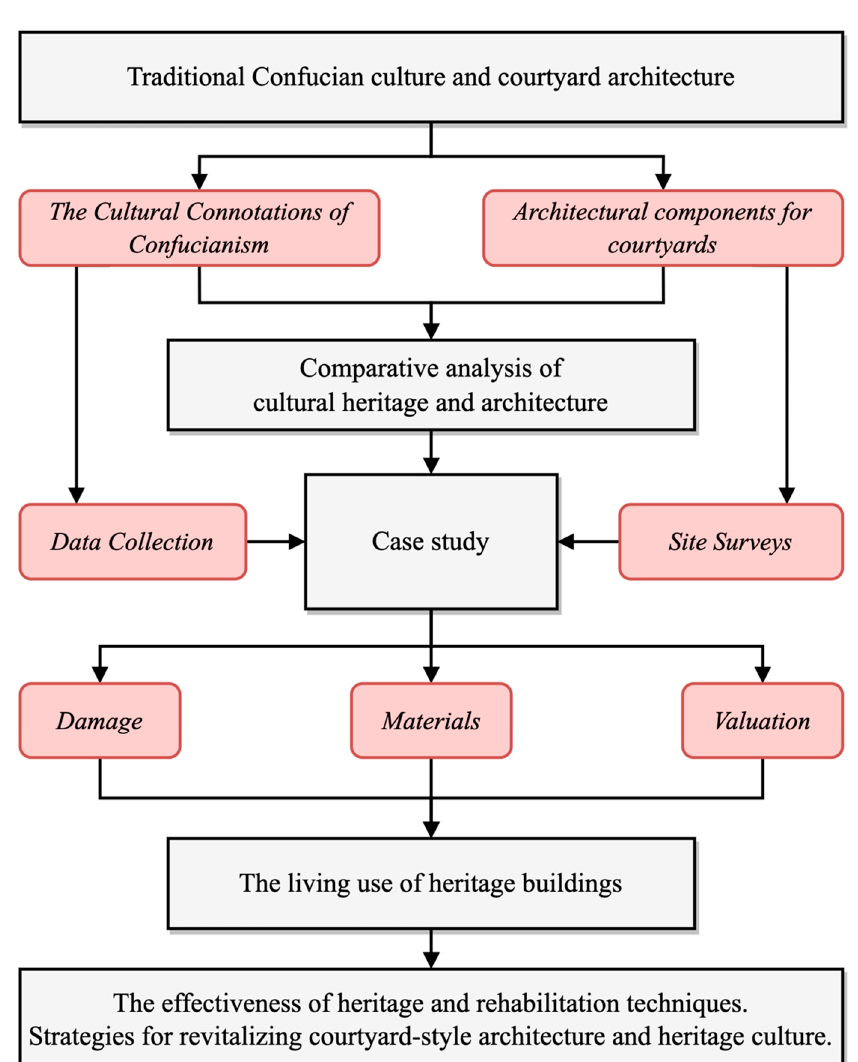
Figure 2. Research framework.